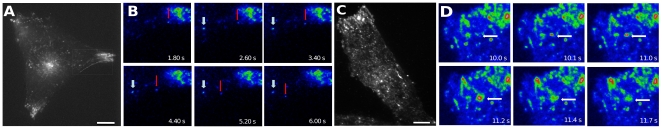
Dynamics of YFP-Langerin in M10 stable cell lines.Maximum Intensity Projection of time lapse video (about 0.8–1 fps) of Langerin-YFP fluorescence (A) and thumbnails temporal series (B) corresponding to the boxed area in (A), recorded in full field illumination fluorescent video-microscopy. Large white arrow shows sudden appearance of fluorescence concentration while thin red arrows identifies lateral movement of a vesicle. The same cell line was imaged using a TIRF microscopy set-up equipped with a very high sensitive EM-CCD camera and a typical Maximum Intensity Projection of a TIRF microscopy video sequence (10fps) is presented in (C). Note that the time regime is different between A and B and that long distance trajectories as detectable in (A) are not present in (C). Thumbnails temporal series (D) of the boxed area in (C) illustrate the time delay between appearance of a fixed spot loaded with Langerin-YFP corresponding to a vesicle entering the evanescent field and docking at a specific site of the cell plasma membrane, its subsequent diffusion and progressive disappearance (D, white arrow).